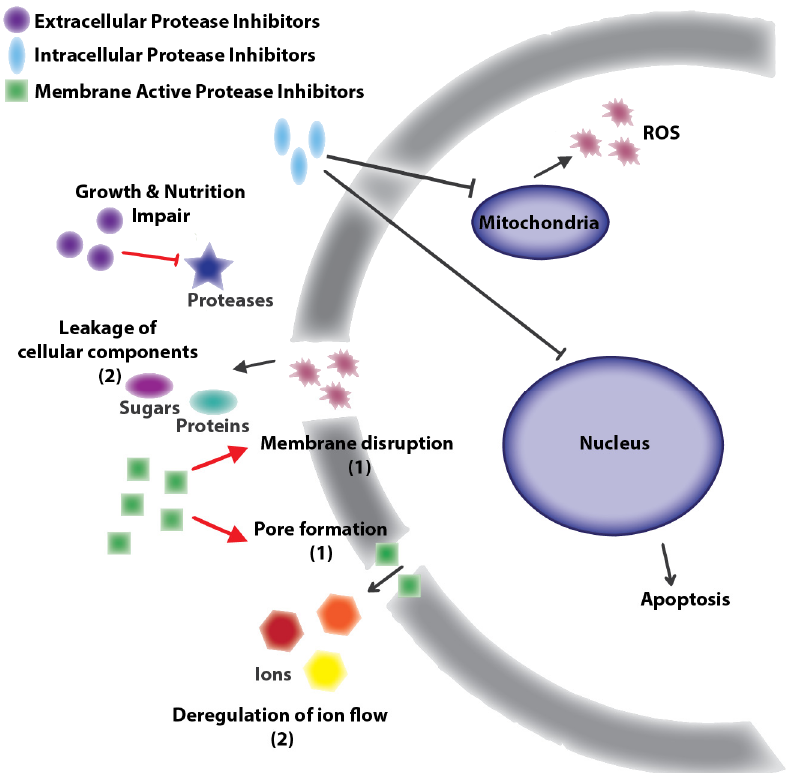
Figure 1. General targets of natural antifungal protease inhibitors: Protease inhibitors with extracellular targets produce nutrition or growth impairment by inhibition of nutrition related proteases [32,42–44]. Protease inhibitors with membrane cell targets cause disruption or pore formation leading to ion (e.g., Na + , K + , Ca 2+ deregulation or leakage of cellular components [30,31]. Finally, protease inhibitors with intracellular targets inhibit mitochondria or nuclear proteases producing reactive oxygen species (ROS) or apoptosis [30,31]. Black lines correspond to antifungal compounds and red lines to molecules with similar antifungal or antibacterial effects.